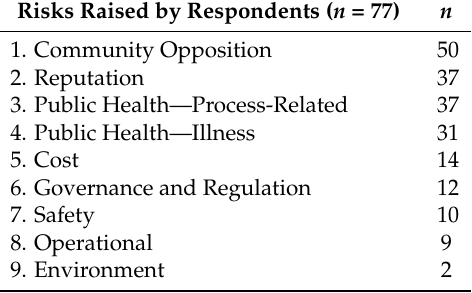
Table 1. Expert risk perceptions associated with the potable recycled water project, and frequency of